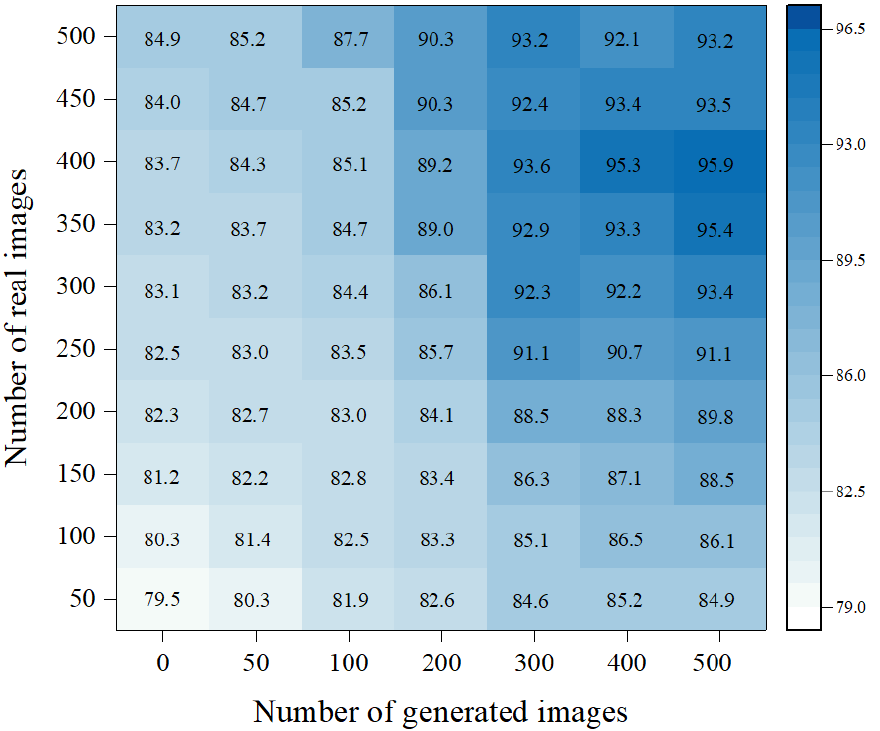
Figure 10. Classification precision for GPR images corresponding to different numbers of field training images and after augmentation with generated data, which are used for training YOLOv4.